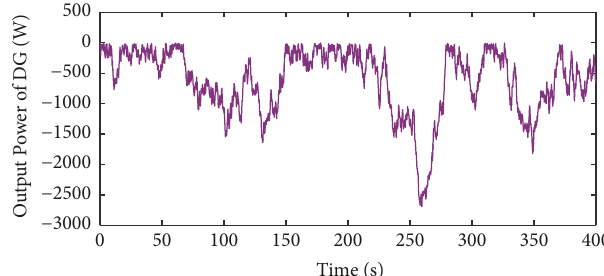
Figure 11: The output power waveform of DG.